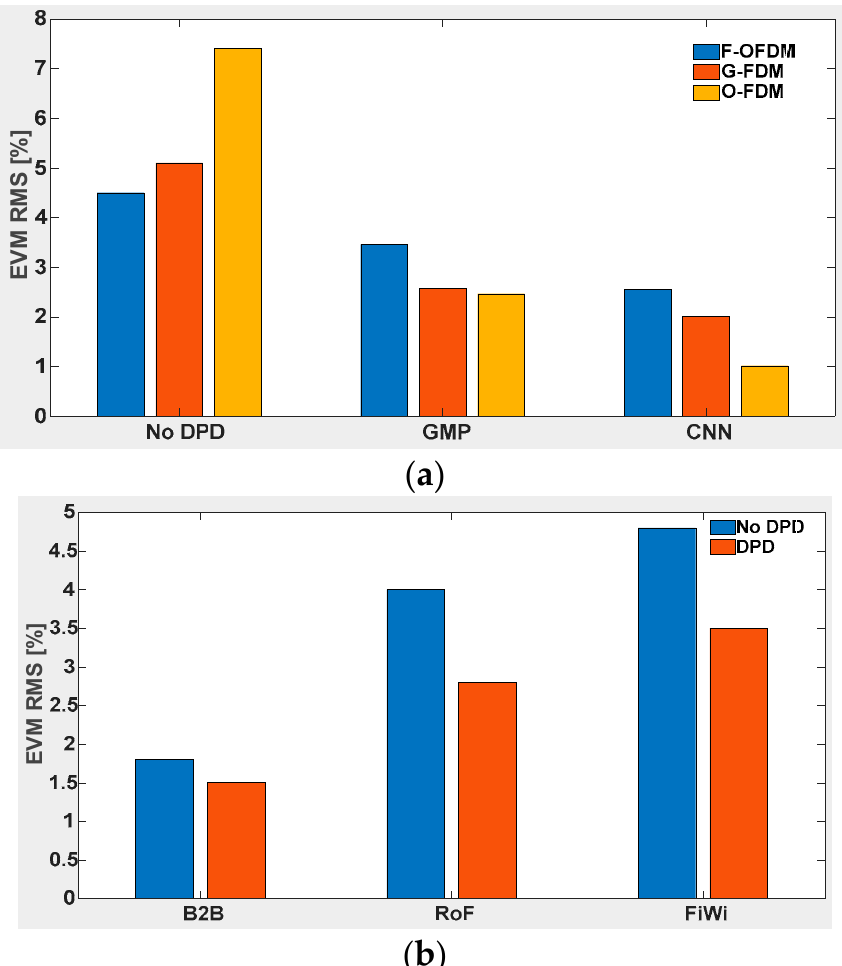
Figure 4. Comparison of EVM for 5G NR and F-OFDM waveforms: ( a ) with GMP, CNN and without DPD for 0 dBm RF input power, while ( b ) with DPD and No DPD for B2B, RoF and FiWi.